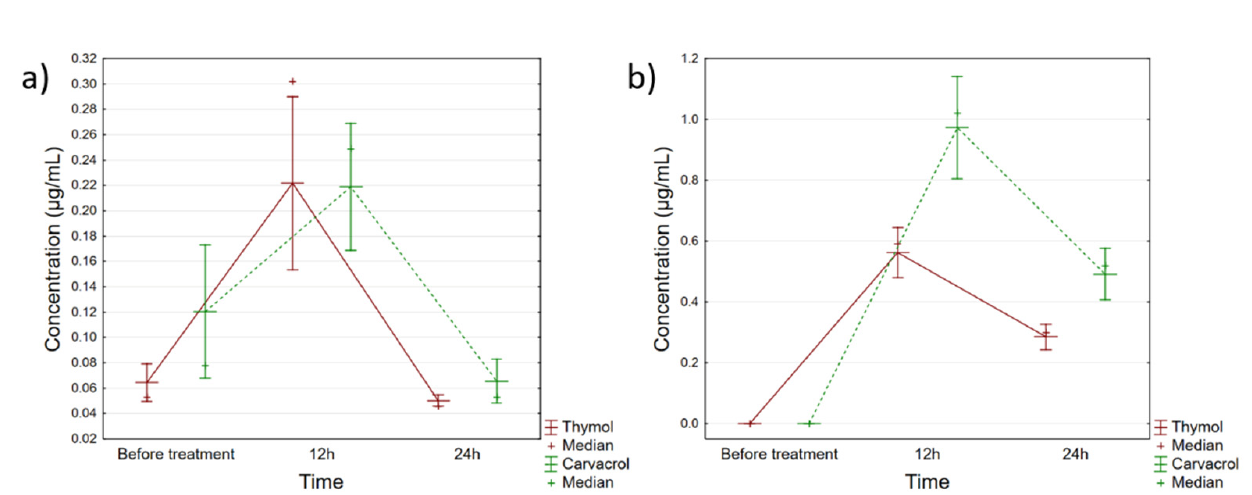
Figure 4. Fluctuations of thymol and carvacrol concentrations in ( a ) milk and ( b ) blood plasma of cows treated with Phyto-Bomat. Vertical bars denote 95% confidence interval.